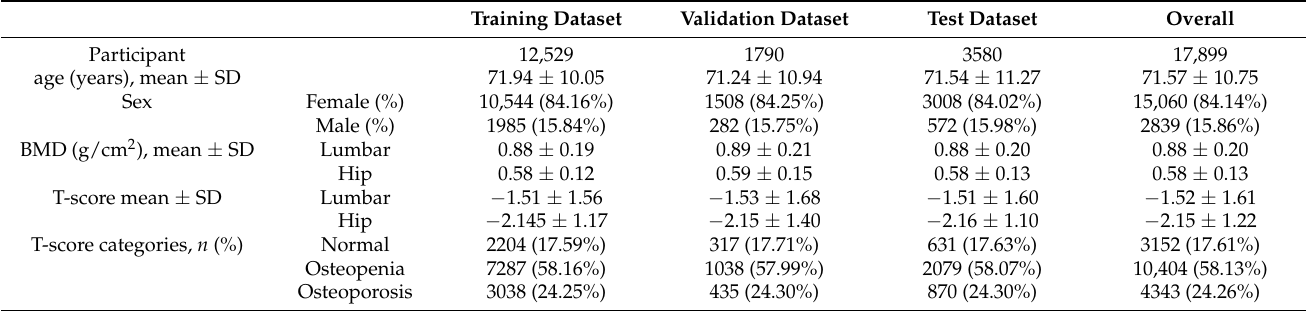
Table 1. Demographic characteristics of the dataset.